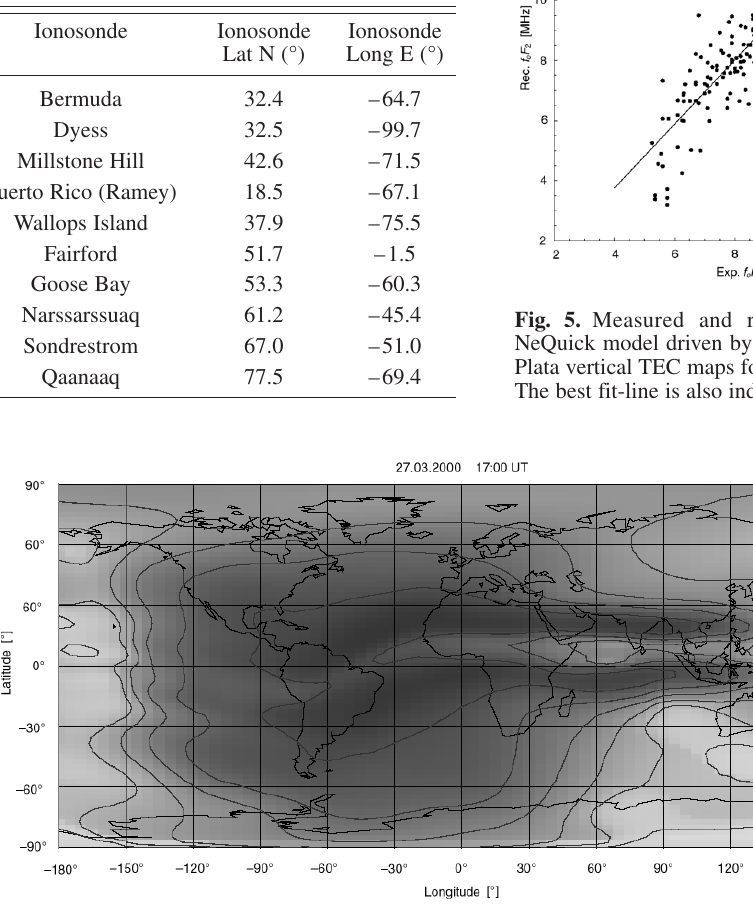
Fig. 6. Example of global f o F 2 map reconstructed using NeQuick model driven by Az grids derived from La Plata vertical TEC maps for the day 27 March 2000, 17:00 UT.